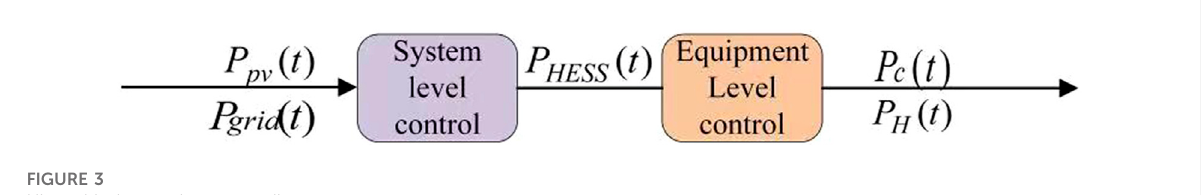
FIGURE 3 Hierarchical control structure diagram.